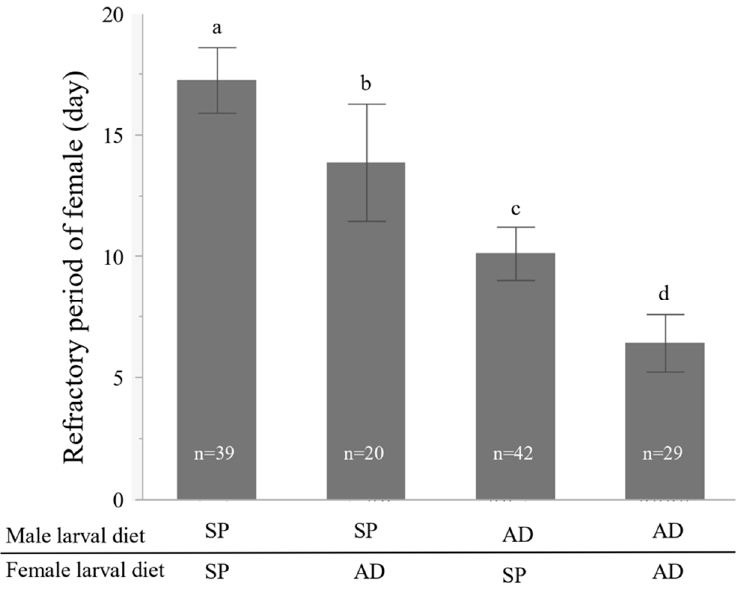
Figure 1. Effects of the male and female larval diet on the refractory period of females (days; mean ± S.E.). On the y-axis, the upper represents the diet of the male larval stage and the lower the diet of the female larval stage. There are two types of larval diet, sweet potato (SP) and artificial diet (AD). Different letters show significant differences (Wald test, p < 0.05).